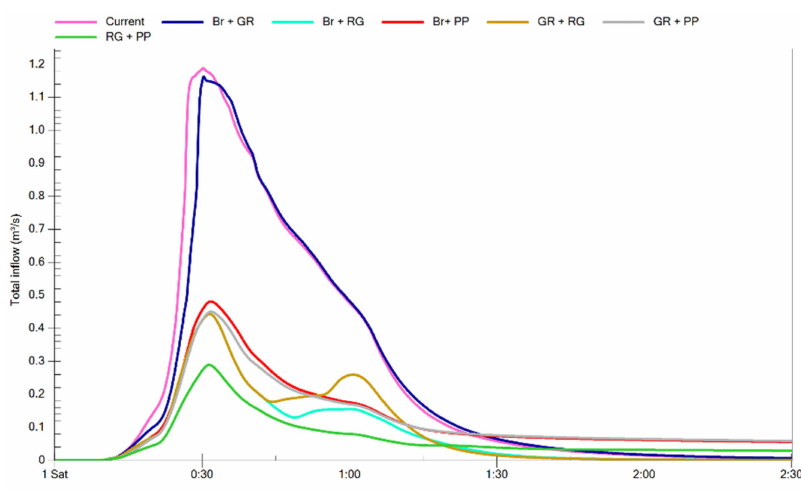
Figure 5. Performances of combinations of two BMPs.